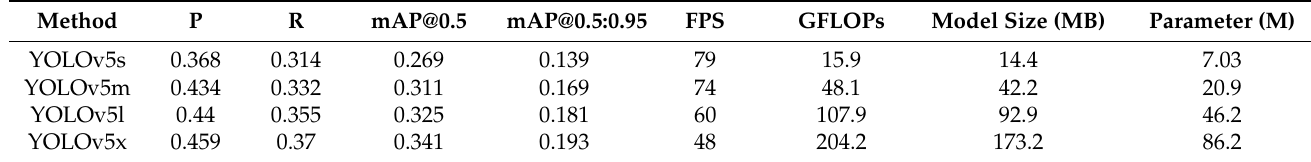
Table 2. Baseline training results for different structures (Visdrone-2019 dataset).